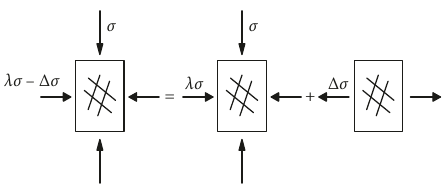
Figure 5: The equivalent unloading stress